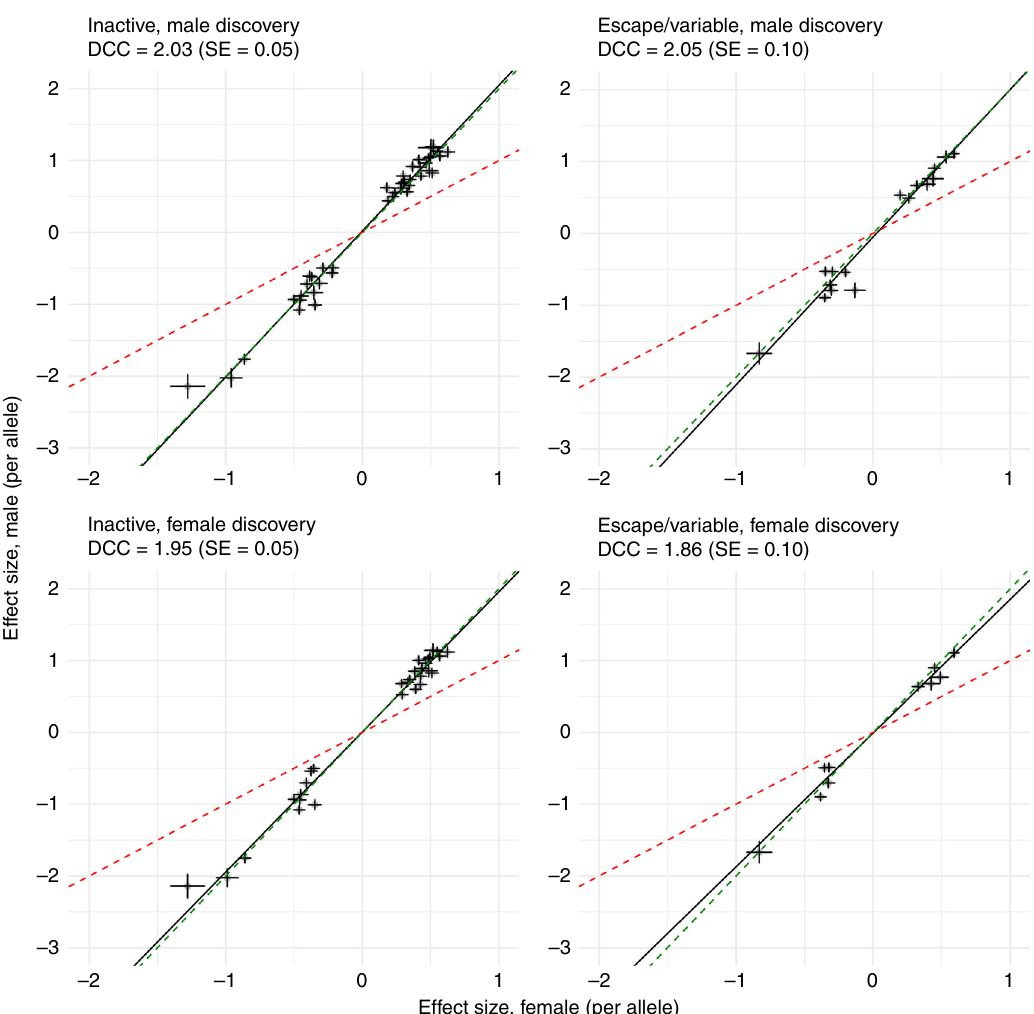
Fig. 3 Dosage compensation coef fi cient (DCC) for eQTLs from blood samples. Comparison of per-allele effects from sex-speci fi c analyses ( + /- SE) for cis - eQTLs identi fi ed in CAGE whole blood. A total of 57/74 and 40/51 eQTLs ( P eQTL < 1.6 × 10 – 10 ) in males and females, respectively, had either Escape, Variable, or Inactive status using annotations from 10 . For 41 inactive eQTLs in the male discovery, DCC is 2.03 (SE = 0.05), and for 16 escape or variable escape eQTLs, DCC is 2.05 (SE = 0.10). For 30 inactive eQTLs in the female discovery, DCC is 1.95 (SE = 0.05), and for 10 escape or variable escape eQTLs, DCC is 1.86 (SE = 0.10). The red dashed line represents the expectation under the escape from X chromosome inactivation (XCI) model. The green dashed line represents the expectation under full dosage compensation model. The black line is the regression line. SE, standard